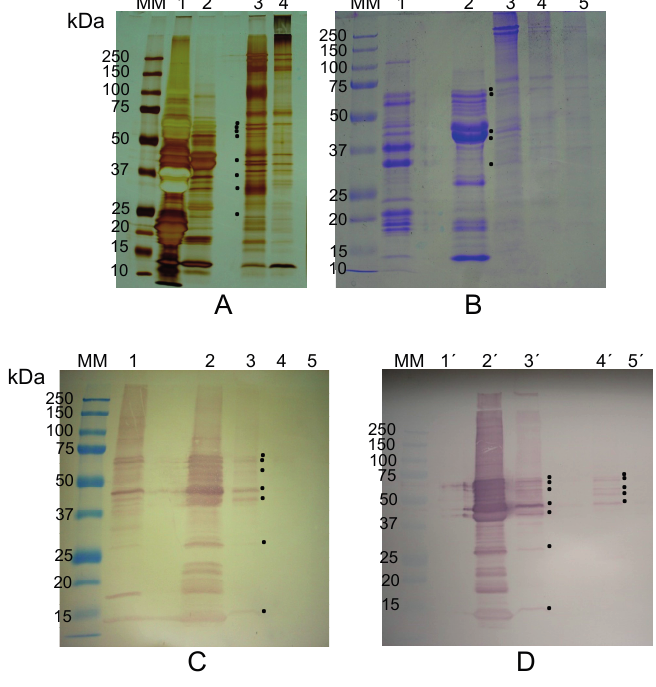
previously incubated with β -lathyrin, but was absent in both the initial and final membranes. Figure 6. ( A , B ) Electrophoretic profile (R-SDS-PAGE; silver nitrate staining in (A), Coomasie Blue R staining in (B)) of total globulins from Lathyrus sativus seeds (lanes 1 and 1’) versus purified β -lathyrin (lanes 2 and 2’). Incubation of erythrocyte membranes with β -lathyrin, followed by R-SDS-PAGE and Coomassie Blue R staining revealed that at least five polypeptides bound to the membranes (lanes 3 and 3’). Lanes 4, 4’ and 5’: controls—initial membrane (lanes 4 and 4’) and final membrane obtained after incubation with β -lathyrin followed by elution with 0.4 M galactose. ( C ) An identical gel was blotted onto a nitrocellulose membrane and incubated with anti- β -lathyrin antibodies. Lanes 1 to 5 have the same meaning as in (B). ( D ) Immunoblot identical to (C); lanes 2’ and 3’: as in (C); elution of the β -lathyrin polypeptides, bound to glycosylated epitopes of the erythrocyte membrane, by mannose (lane 4’) and galactose (lane 5’). Molecular masses of standards (MM) are indicated in kDa. Black dots indicate polypeptides bound to or eluted from erythrocyte membranes. MM 1 2 3 4 MM